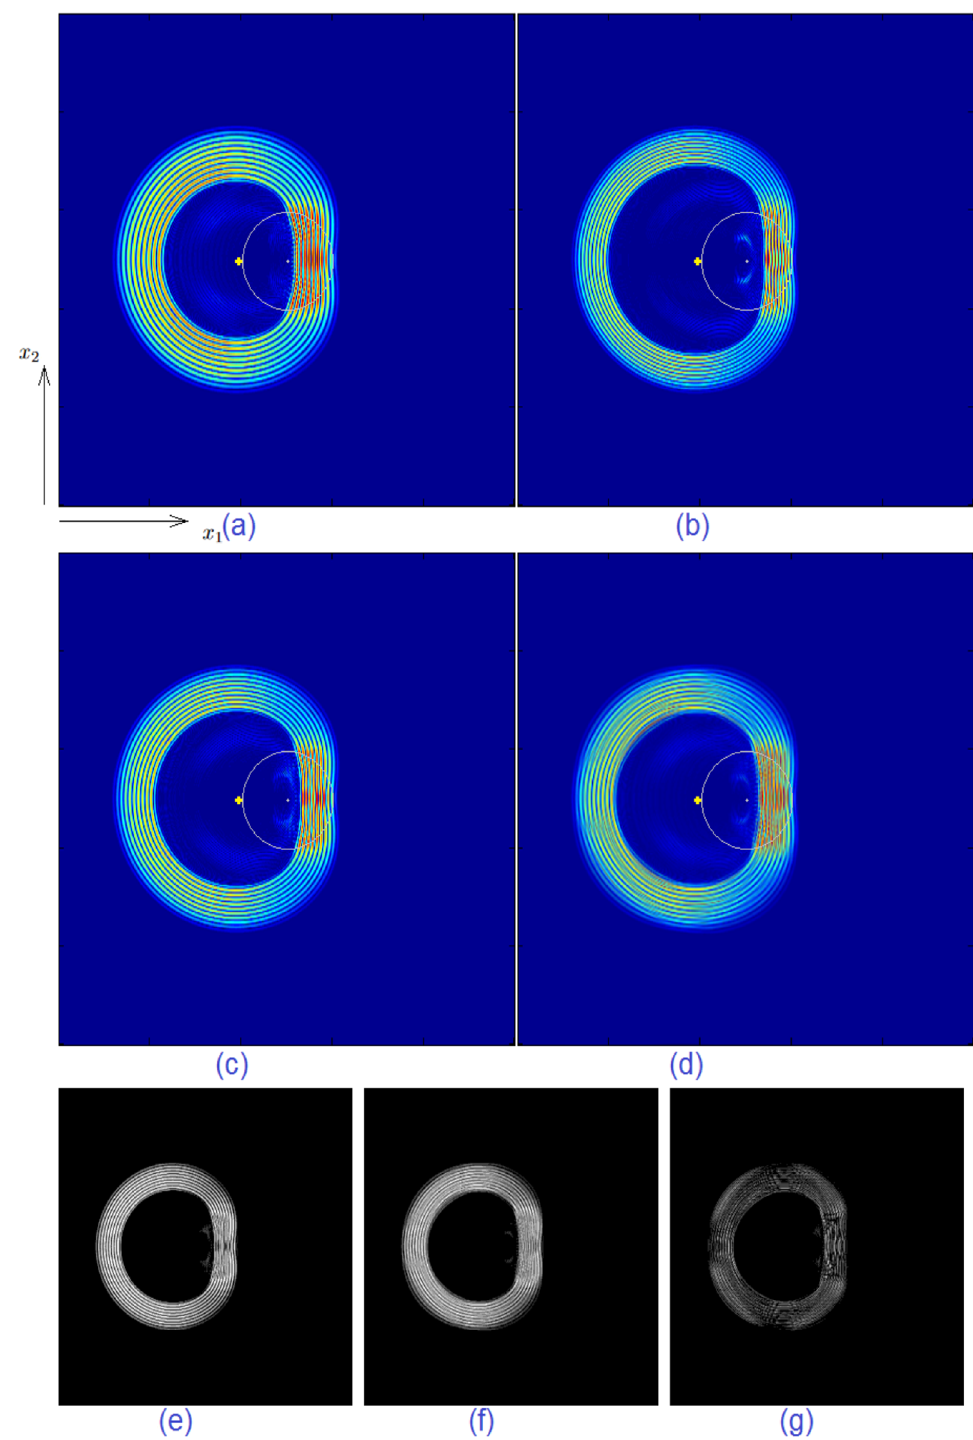
Fig. 9. Snapshot time t = 480 m s, for the radiation pattern of a point force directed along x 1 , and located at 5.5 cm from the center of a Luneburg lens with a radius of 5 cm based in the center of a fi eld of 50cm by 50 cm, with a frequency of 25kHz (a), 35 kHz (b) and 30kHz (c); morphing result (d) between (a) and (b), (e) is (c) transformed in a grayscale image, (f) is (d) transformed in a grayscale image and (g) is the absolute value of the difference between (e) and